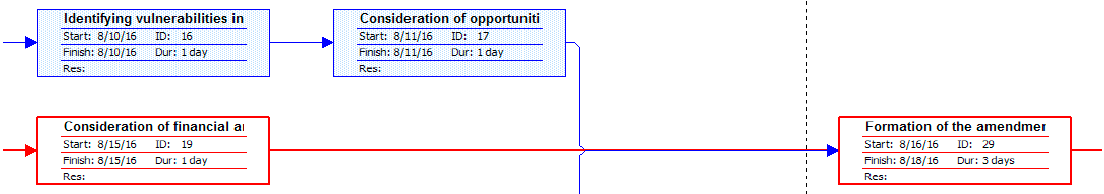
Figure 8. Illustrative part of the network plan of the branched project structure to improve the environmental protection system in mining and energy complexes.